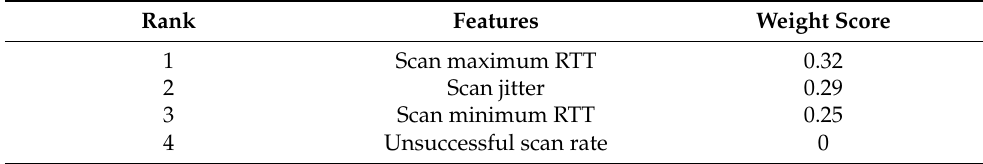
Table 3. An example of features ranking